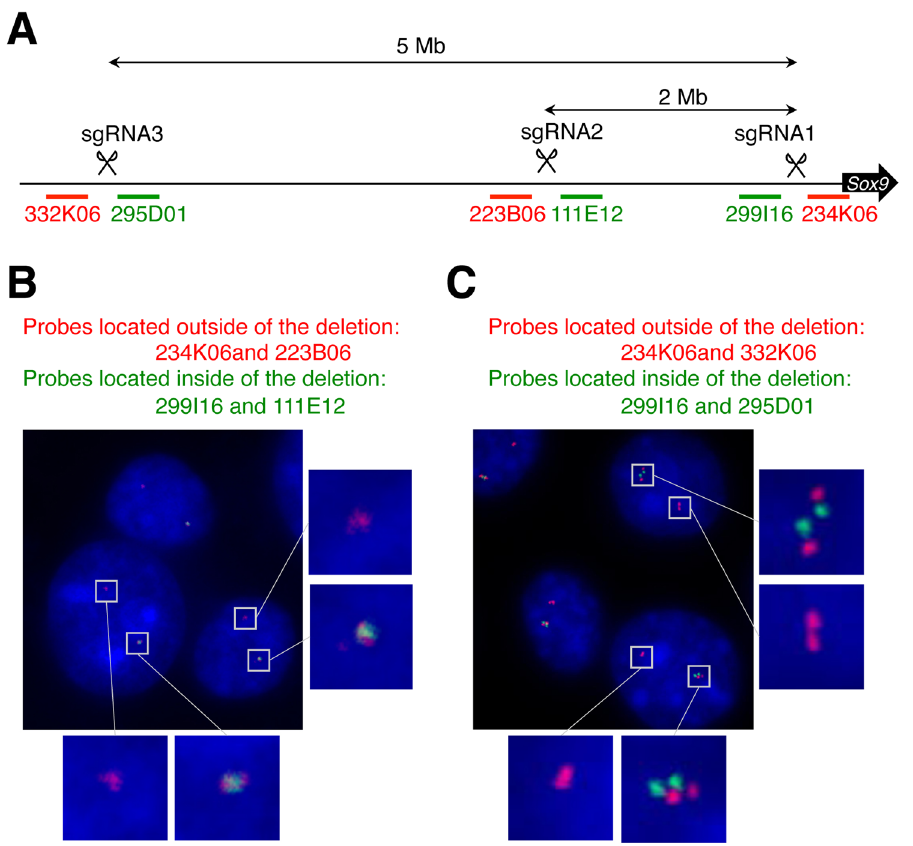
Figure 5. FISH analysis of 2-Mb and 5-Mb deletions. ( A ) Schematic representation of the positions of BAC probes. BACs located within the sgRNAs are shown with green lines and letters, and those outside in red lines and letters. ( B , C ) Representative nucleus images of DNA FISH analysis of fibroblasts obtained from #48 embryo of Fig. 1 ( B , 2-Mb deletion) and #13 embryo of Fig. 2 ( C , 5-Mb deletion). Probes that we used are indicated at the top of the images with probe colors. Enlarged images of boxed areas are placed on the